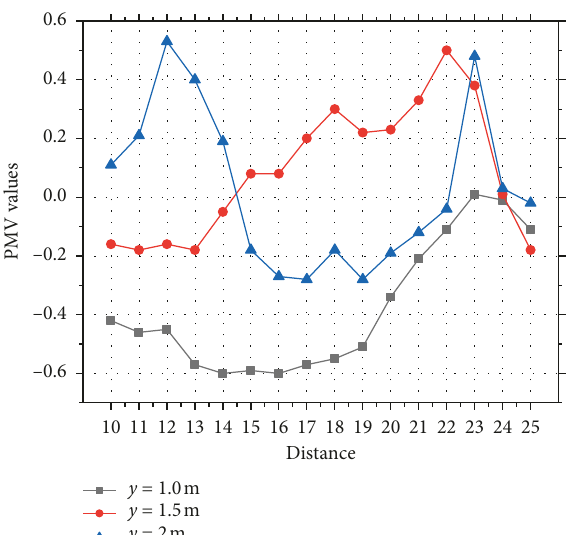
Figure 12: PMV values at different heights of the roadway.